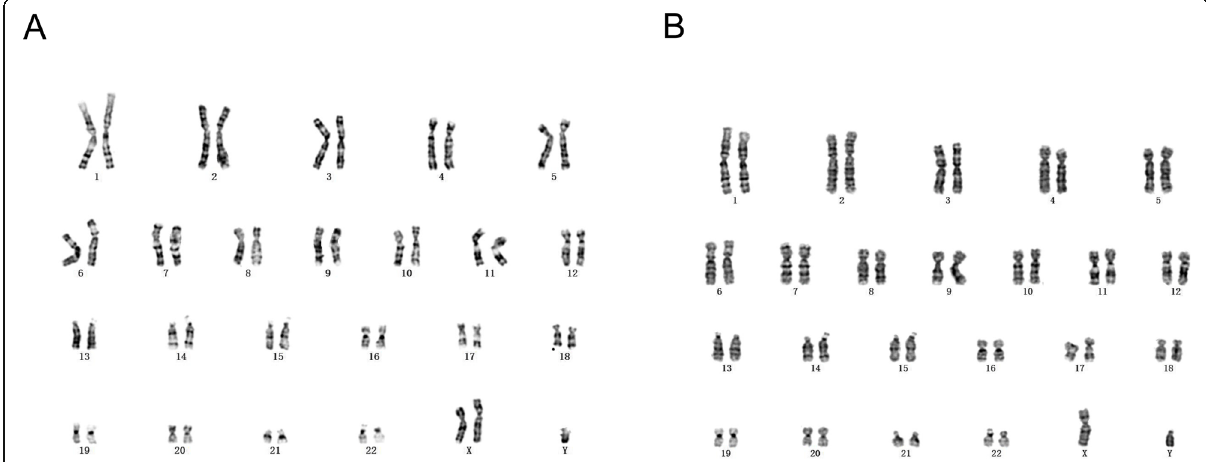
Fig. 2 Metaphase spread in GTG-banding obtained from the amniocentesis at the 19th week of gestation. The result is 47, XXY [19] ( a )/ 46,